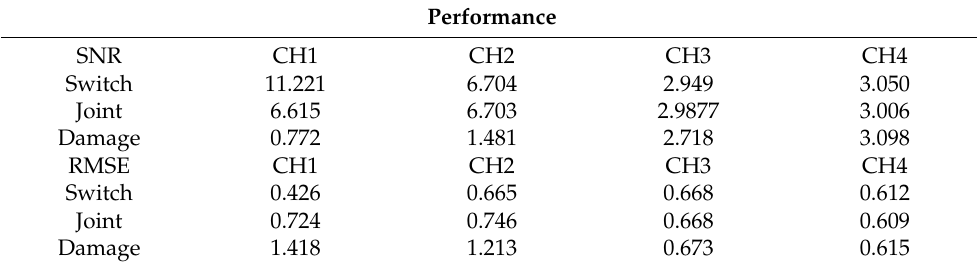
Table 8. The maximum information coefficient (MIC) of different channels under different rail states.